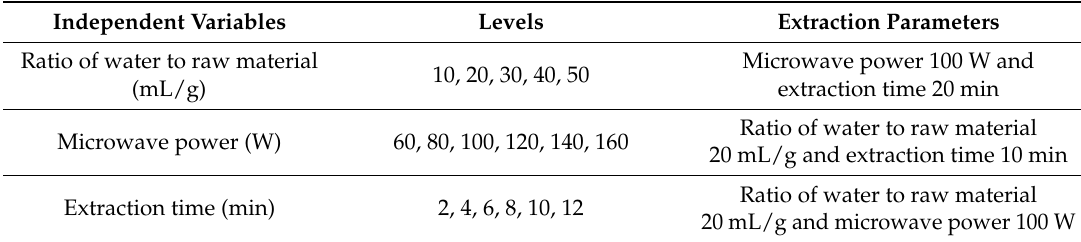
Table 5. Independent variables and their levels used for single factor experiment.